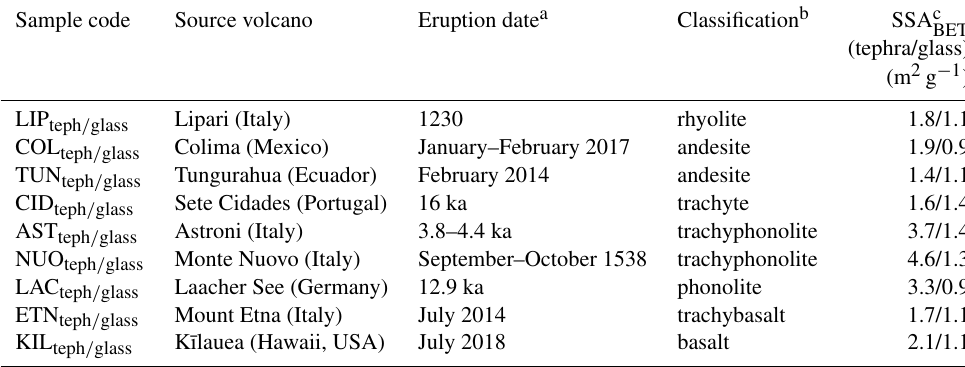
Table 1. Details of the volcanic tephra and glass samples used in this study.